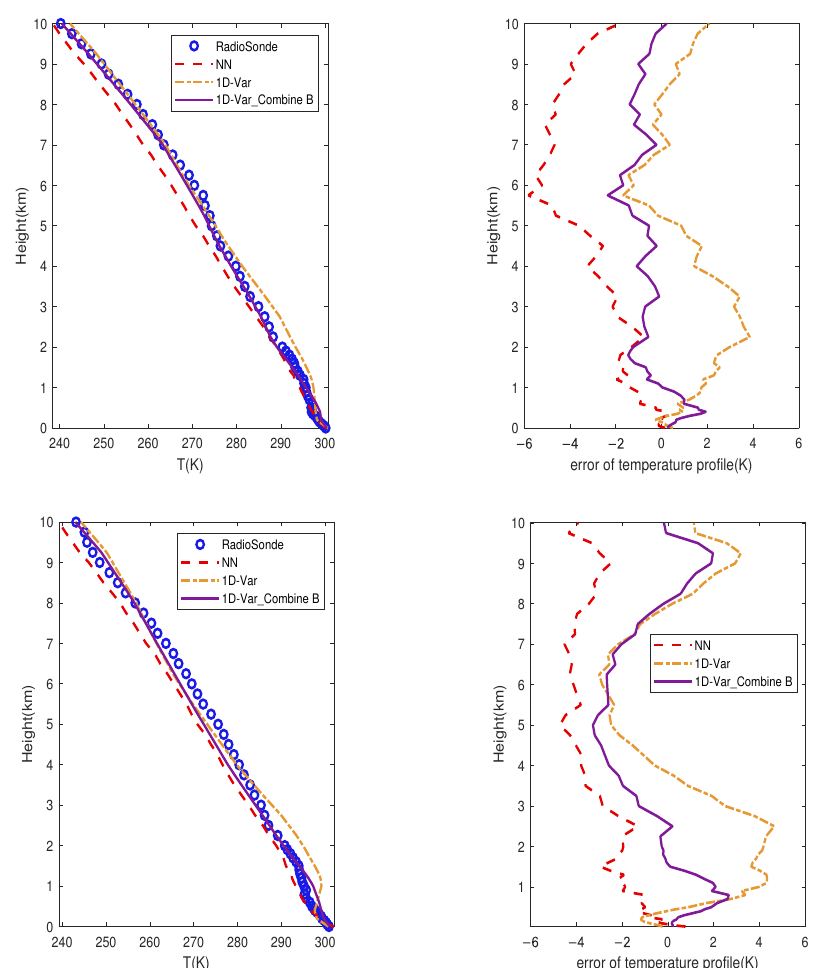
Figure 4. Temperature ( left ) and temperature error ( right ) profiles observed by the radiosonde and retrieved using various retrieval algorithms, at UTC 00:00 ( top row ) and 12:00 ( bottom row ), 8 July